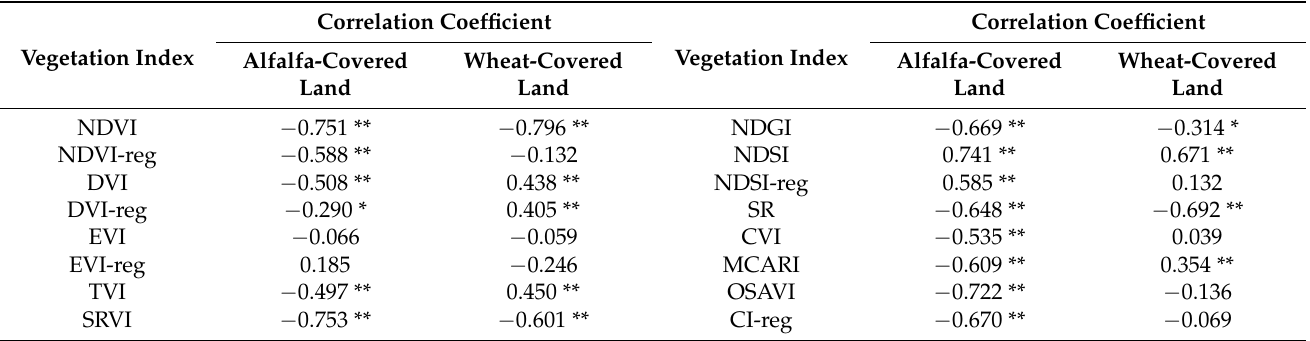
Table 6. The correlation between the vegetation index and the soil salt content for the alfalfa- and wheat-covered